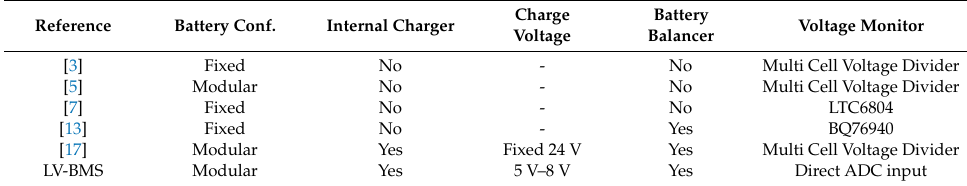
Table 4. Comparison with previous